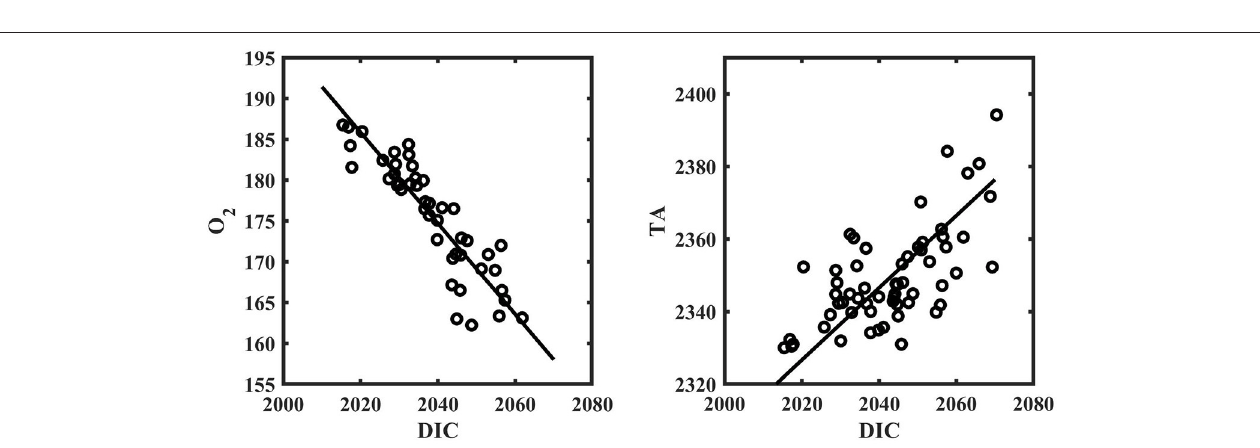
FIGURE 4 | Spatial contour plots for O 2 [ µ mol kg − 1 ] (A–C) , nDIC [ µ mol kg − 1 ] (D–F) , and nTA [ µ mol kg − 1 ] (G–I) from the morning of July 27 (left column), afternoon of July 27 (middle column), and morning of July 29 (right column). Contours are 5 µ mol kg − 1 for all plots. Red indicates where sensors were deployed, and the red star indicates where BEAMS was